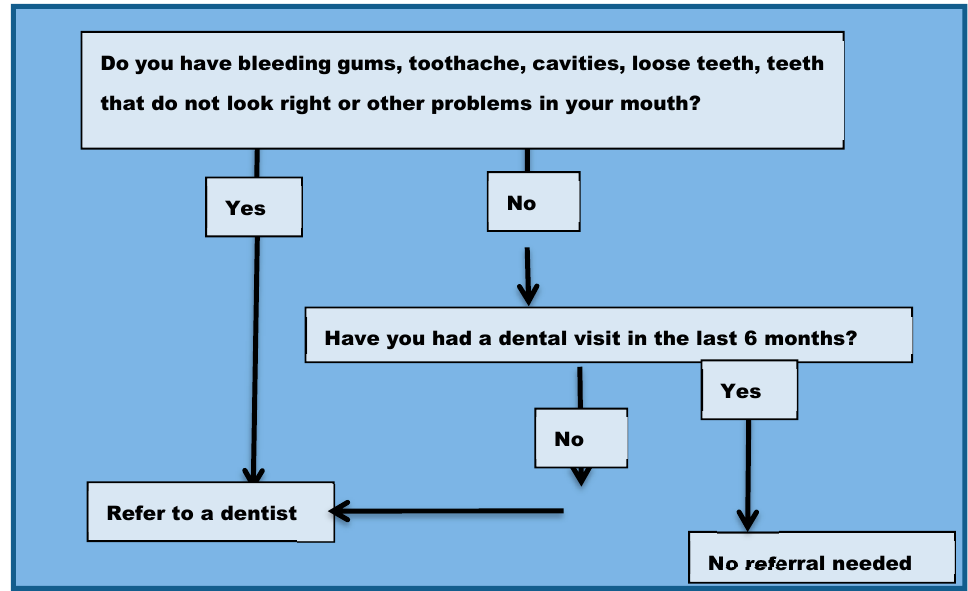
Figure 1. Dental referral algorithm.